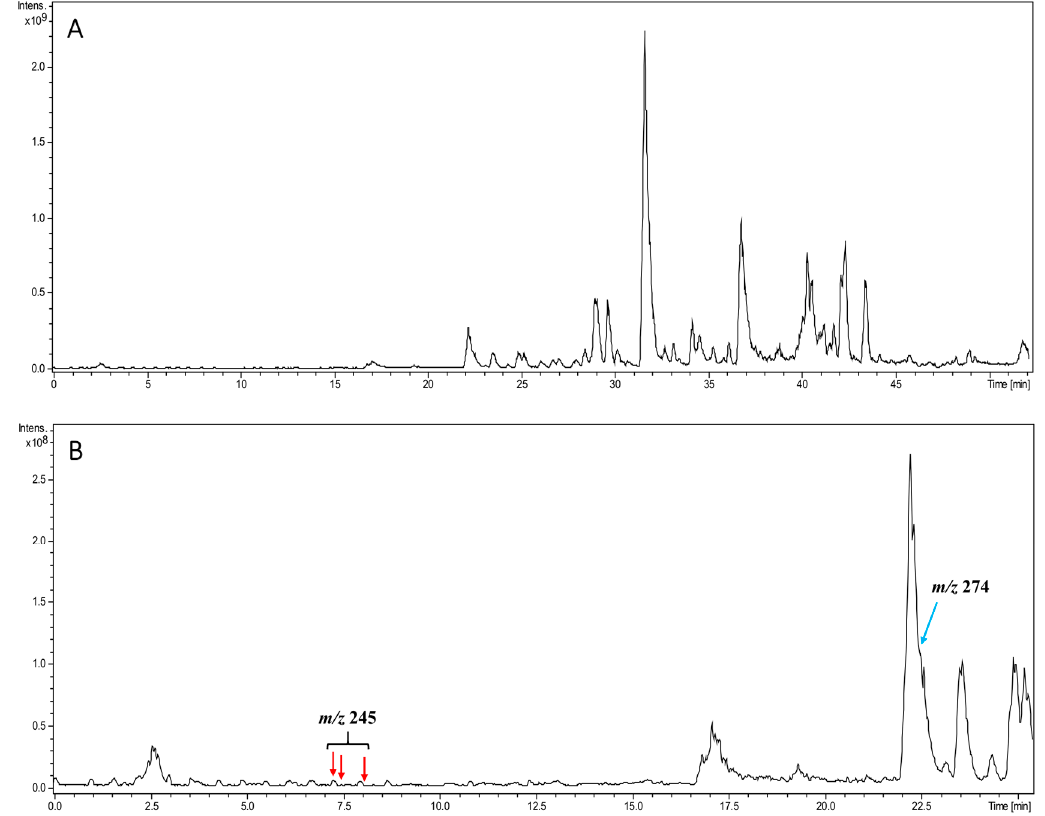
Figure 3. ( A ) The total ion chromatogram of culture pellet residues from X. fastidiosa 9a5c grown in